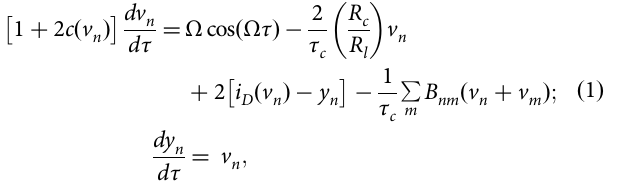
where the symbols are de fi ned as follows in terms of the measurable = V circuit quantities: v n / A , with A being the amplitude of the driving n signal and V n the voltage across the diode; y n = Y n /( AC d ω 0 ), with Y n representing the current through the inductor. Similarly, i D = I D / ( AC d ω 0 ), where I D ( V ) is the voltage-dependent current through the varactor diode. C ( V ) is the voltage-dependent capacitance of the diode, and c = C ( V )/ C d . (Both functions, I D and C , are given in the Methods ffiffiffiffiffiffiffiffi p ¼ 1 = section.) Furthermore, ω LC and τ = ω 0 t , and Ω = ω / ω 0 0 d